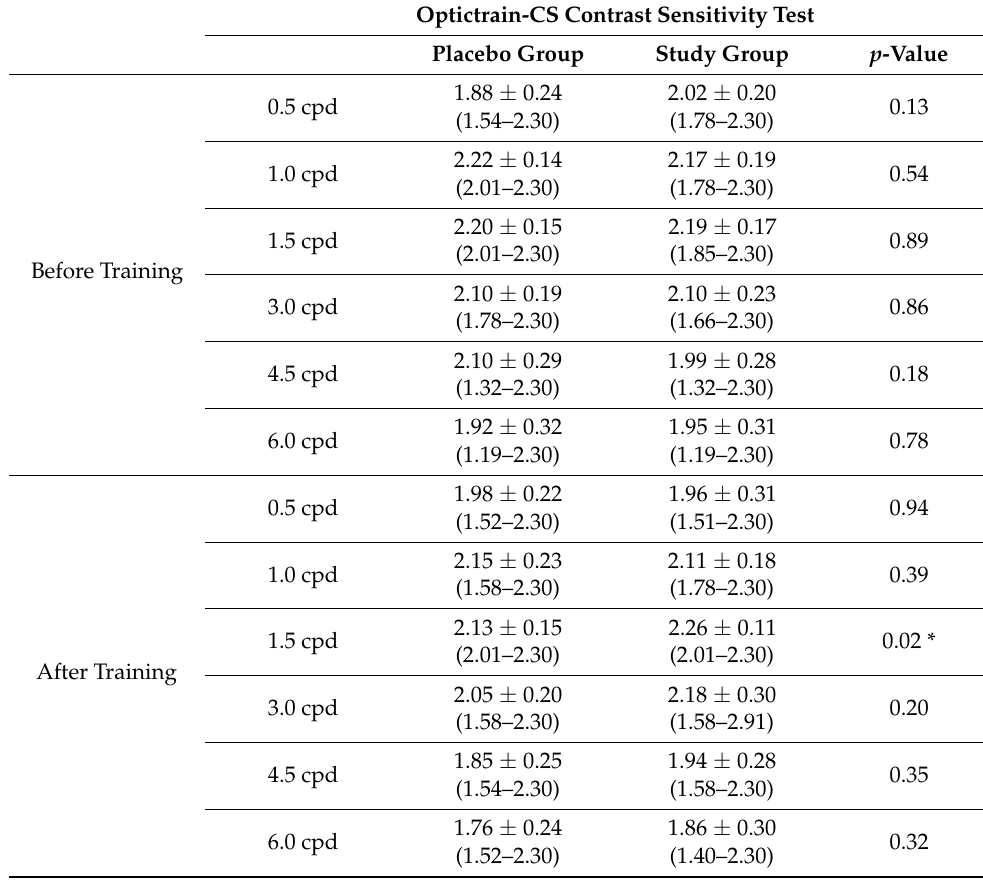
Table 4. Near contrast sensitivity results obtained before and after the training with the Optictrain- CS test. Mean ± standard deviation (minimum and maximum) of contrast sensitivity values are represented in logarithmic units (logCS). Differences between groups were assessed with the Mann– Whitney test, and statistically significant differences ( p < 0.05) are marked with an asterisk (*). Optictrain-CS Contrast Sensitivity Test Placebo Group Study